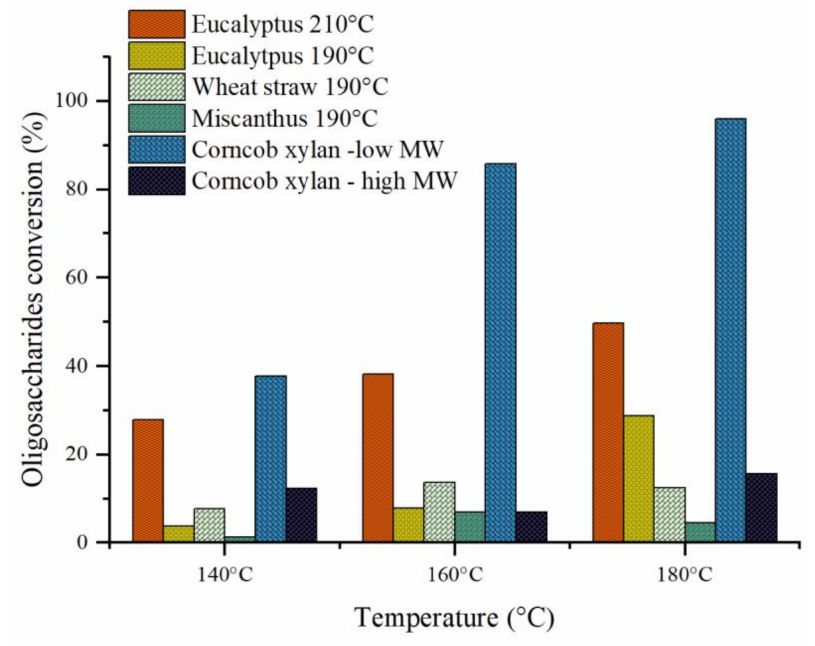
Figure 4. OS conversion during catalytic hydrolysis.